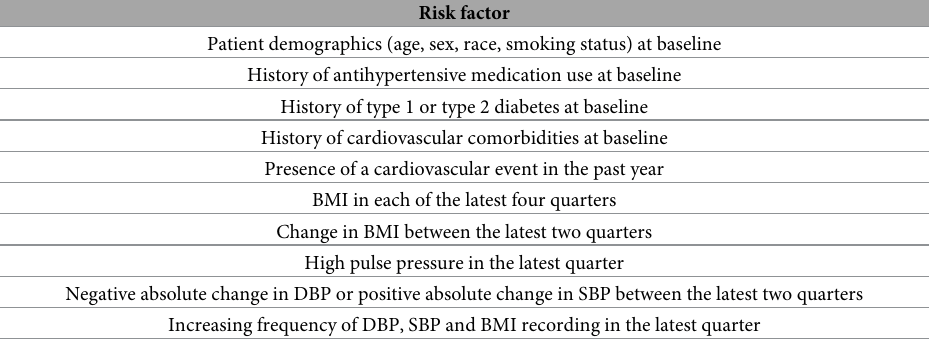
Table 2. Summary of key AF risk factors inferred from the final risk model. Risk factor Patient demographics (age, sex, race, smoking status) at baseline History of antihypertensive medication use at baseline History of type 1 or type 2 diabetes at baseline History of cardiovascular comorbidities at baseline Presence of a cardiovascular event in the past year BMI in each of the latest four quarters Change in BMI between the latest two quarters High pulse pressure in the latest